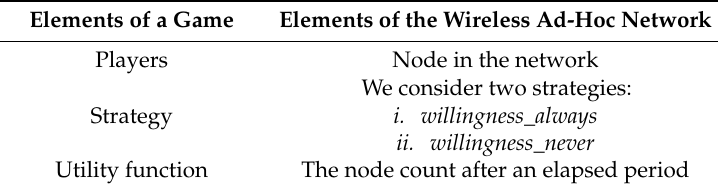
Table 3. The duality of game and wireless ad-hoc